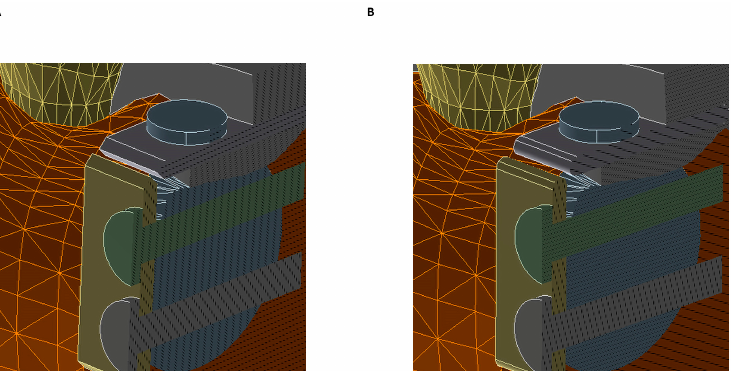
Figure 3. Zoom of: ( A ) Simulation of a thin bone block with right-angled edges, ( B ) Simulation of a thin bone block with rounded edges (different colors are used to distinguish different parts of the model).